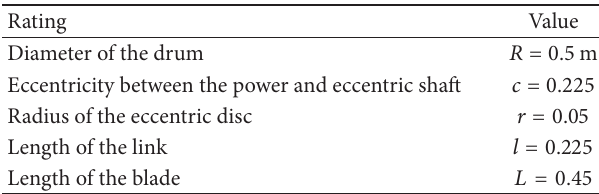
Table 1: VAT characteristics.